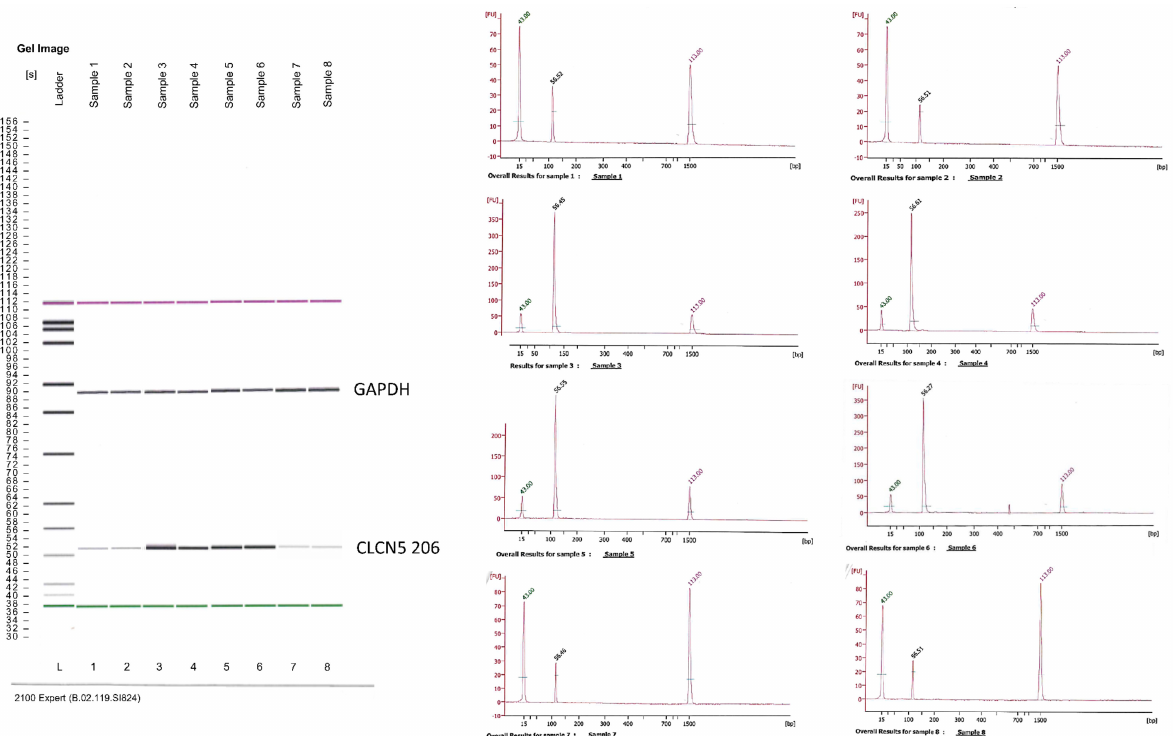
Figure 9. Qualitative RT-PCR analysis of the CLCN5 -206 isoform mRNA. Image generated by the Agilent 2100 bioanalyzer of amplified housekeeping gene (glyceraldehyde 3-phosphate dehydrogenase— GAPDH ) and CLCN5 -206 isoform in CLCN5 − / − (Lines 1 to 4: lines 1–2 CTR, lines 3–4 30 mg/mL of albumin after 48 h of exposure) and WT clones (Lines 5 to 8: lines 5–6 CTRL, lines 7–8 30 mg/mL of albumin after 48 h of exposure). Chromatograms refer to CLCN5 -206 isoform amplicons. Image is representative of the results of three independent experiments.